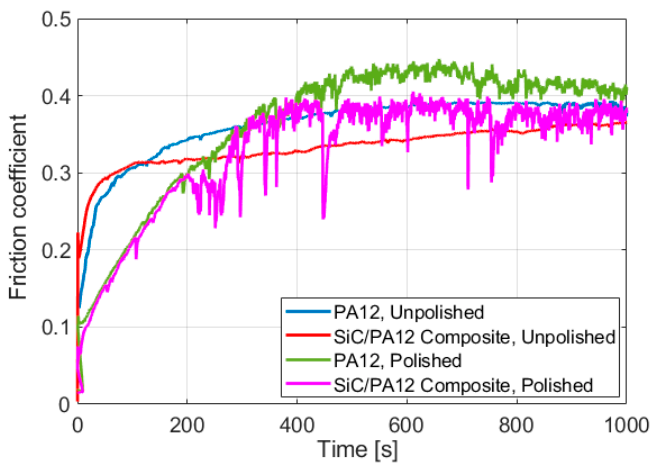
Figure A1. Friction coefficient of PA12 and SiC/PA12 composites for unpolished and polished cases.